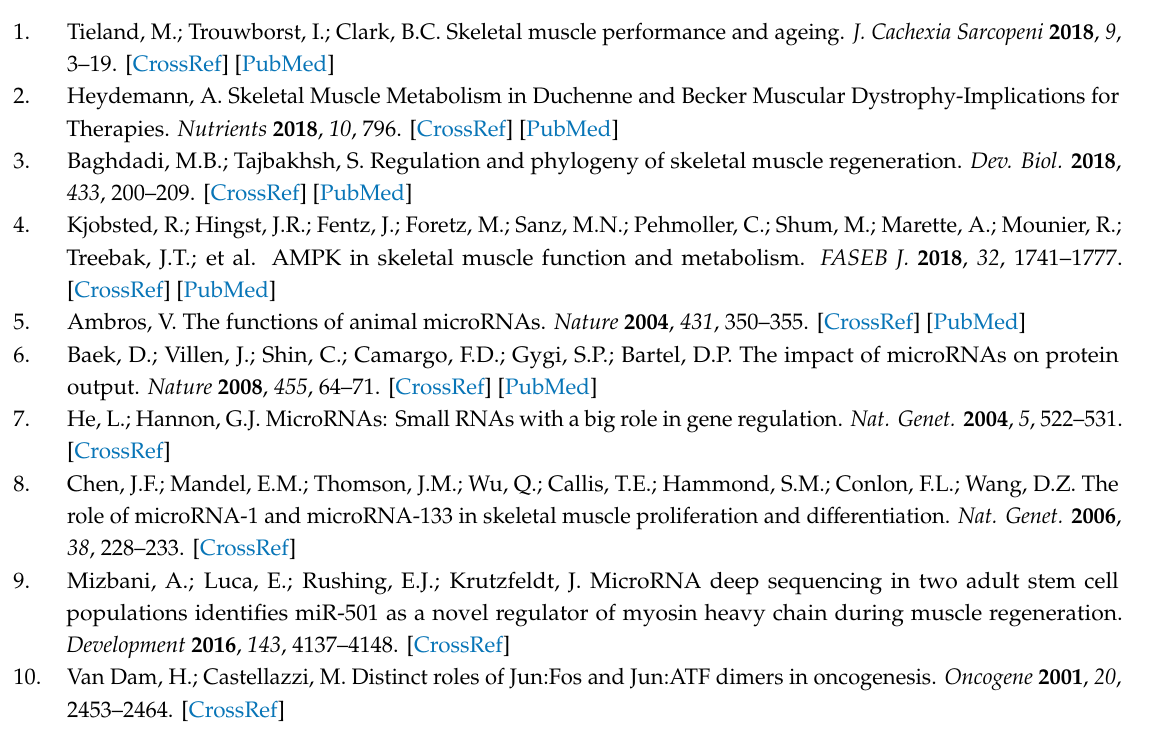
quantitative results for Figure 3E. Supplementary Figure S3. WB bands quantitative results for Figure 4E. Supplementary Figure S4. WB bands quantitative results for Figure 5E. Supplementary Figure S5. WB bands quantitative results for Figure 6E. Supplementary Figure S6. pcDNA3.1-FOS